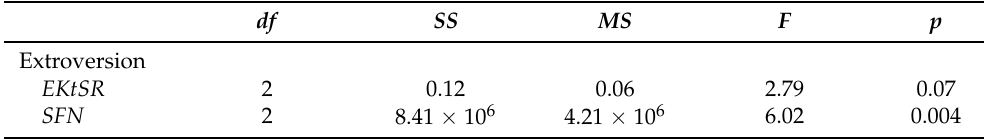
Table 3. Selected MANOVA results for variance in Freud me out 2 statistics by NEO-FFI results.